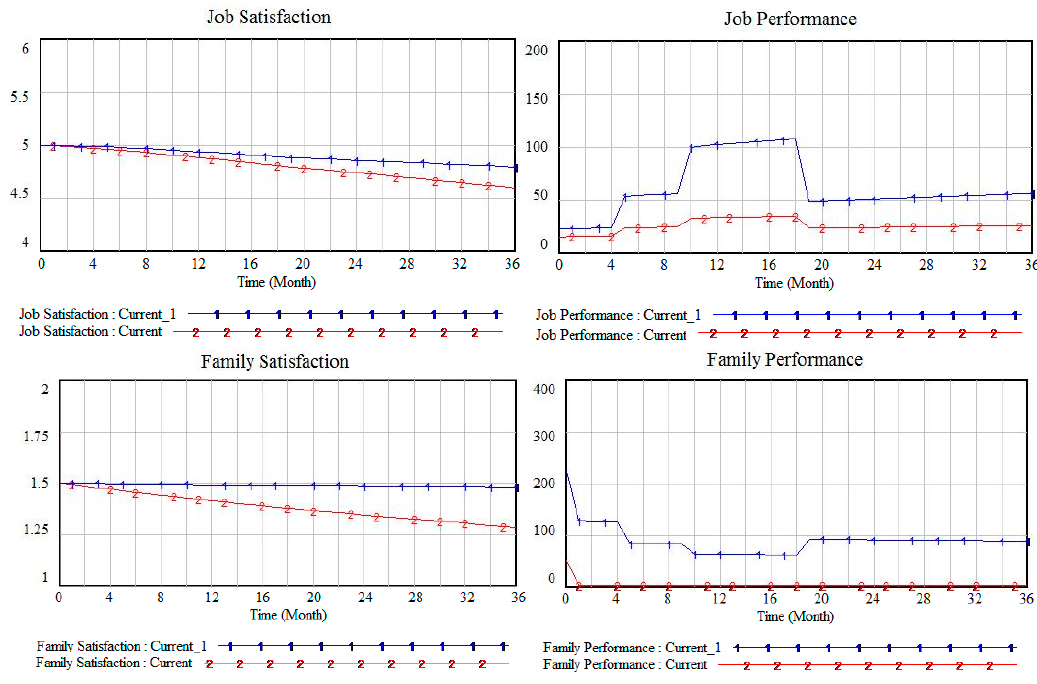
Figure 6. Satisfaction and performance under different work flexibility.